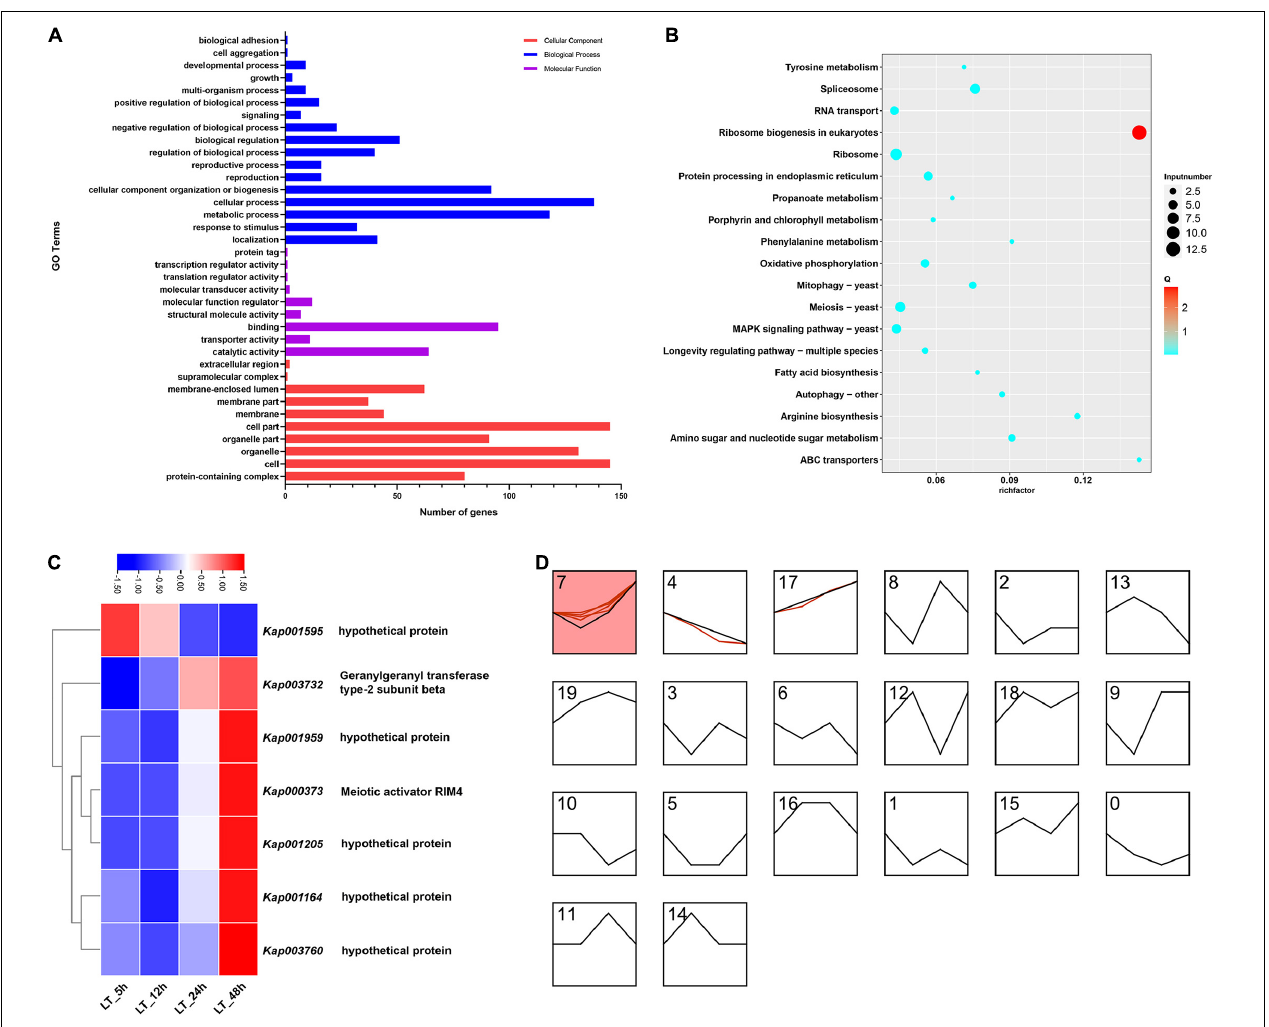
FIGURE 4 | Bioinformatics analyses of DEGs of K. apiculata with low temperature treatment. (A) GO category of total DEGs. (B) KEGG enrichment pathway of total DEGs. (C) Heat map of common DEGs. (D) Expression patterns analysis of